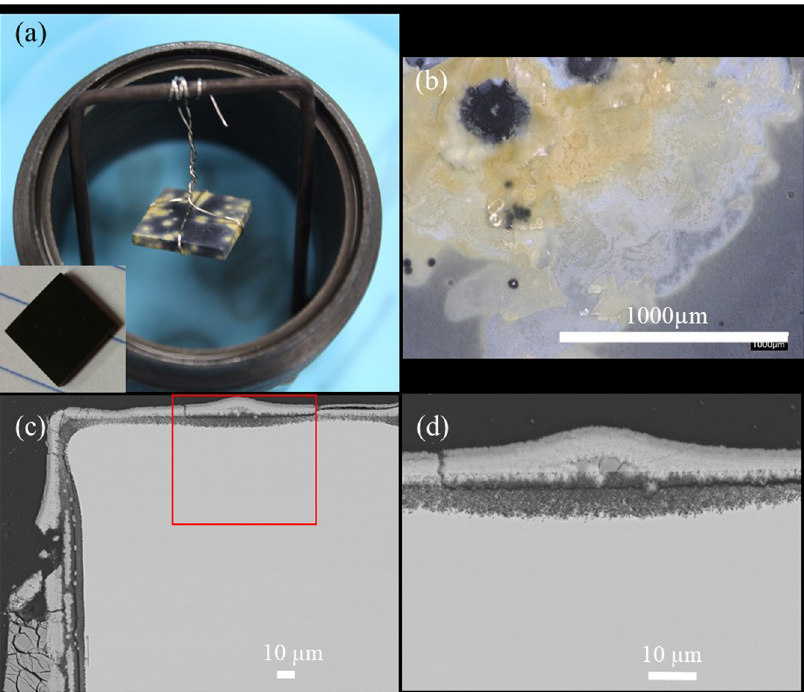
Fig. 6 Dike amphibolite coupon after the 49-day VHT. a The post-reaction coupon suspended from the stainless-steel apparatus at the end of the reaction (inset shows pre-reaction coupon), ( b ) optical micrograph of a corroded area on a coupon surface, ( c ) and ( d ) BSE-SEM cross sections at different magni fi cations (the red box is the area associated with ( d